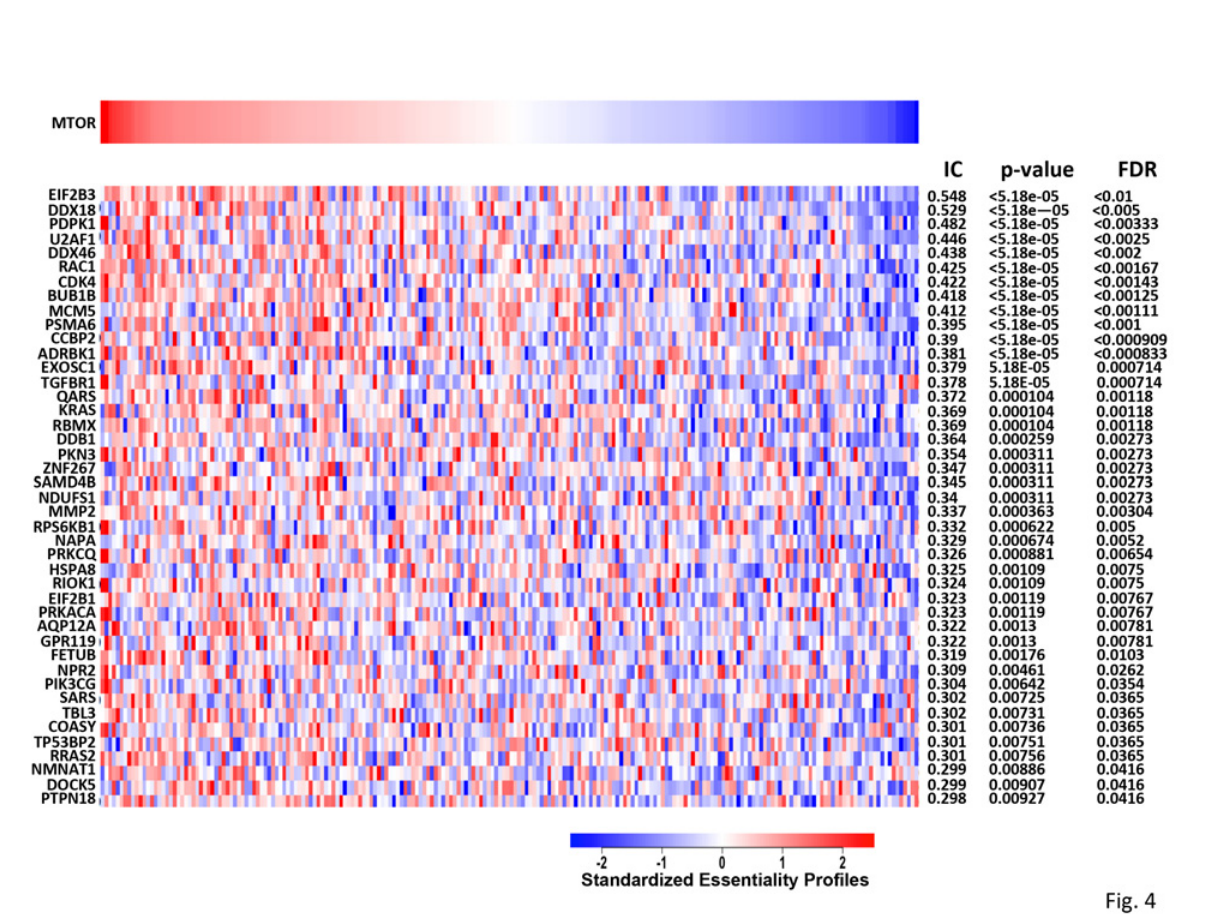
Fig 4. Confirmed S6-P positives whose depletion affects the viability of a panel of cell lines similar to that of mTOR depletion. This heat map shows the standardized essentiality profiles (blue more essential, red less essential) of 43 S6-P positives genes that are also significantly associated (FDR < 0.05) with mTOR essentiality (left). The association is determined by the normalized mutual information (IC score, nominal p value and FDR are shown at the